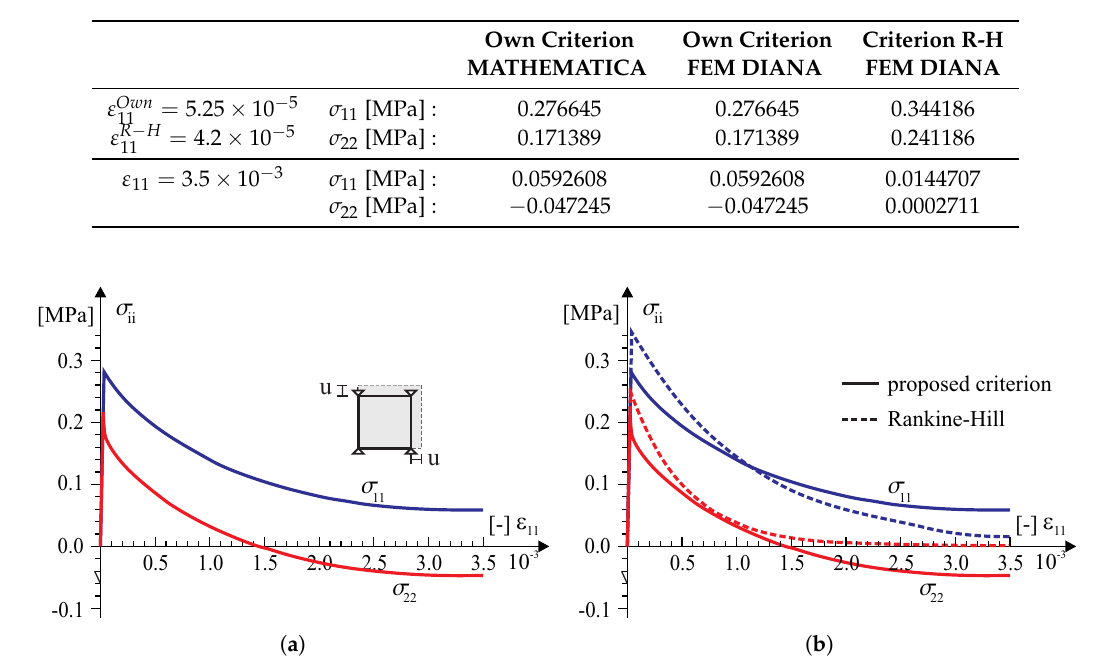
Figure 11. A strain field ε 11 > 0 and ε 22 > 0 single element test results: ( a ) symbolic computation by